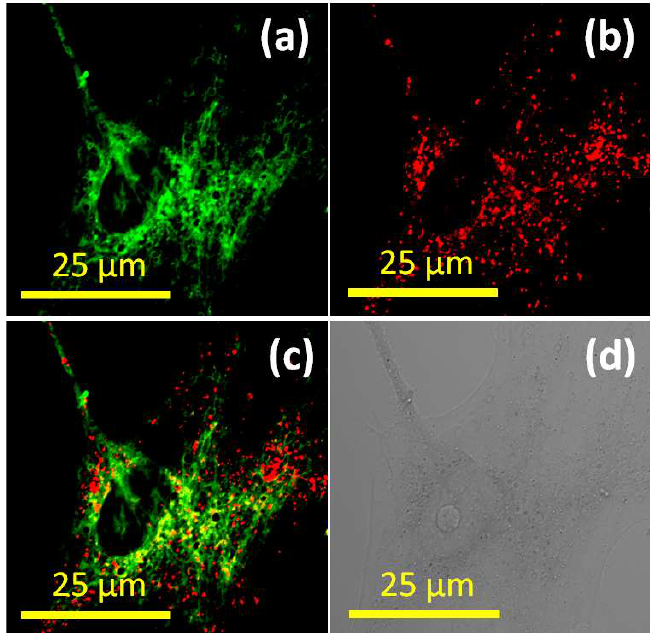
Figure 2. Fluorescence confocal microscopy images of the MO3.13 cells incubated with probe 3b (200 nM) for 30 min in the presence of MitoTracker TM Green FM (200 nM). Figures represent the staining of the MitoTracker TM Green ( a ), the staining of 3b ( b ), composite image ( c ), and the bright field ( d ). Probe 3b was excited with 561 nm laser line and the MitoTracker TM Green was excited with 488 nm laser line. The emission filter settings were set up to collect from 495 to 530 nm (MitoTracker TM Green) and 575 to 750 nm ( 3b ),